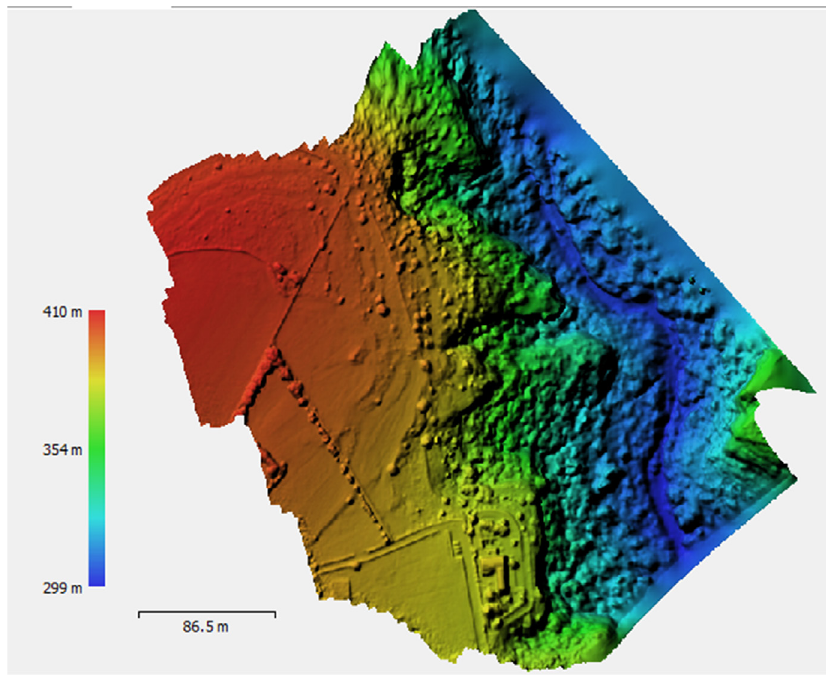
Figure 10. Shaded Digital Elevation Model (DEM).